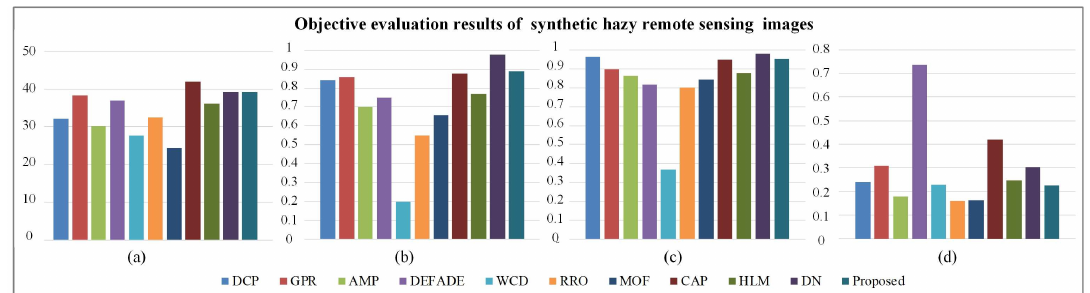
Figure 13. Objective evaluation results of eleven image dehazing methods in synthetic hazy scenes: ( a ) PSNR ; ( b ) SSIM ; ( c ) TMQI ; ( d ) FADE . The higher values of the PSNR , SSIM , and TMQI indexes are better, the lower value of the FADE index is